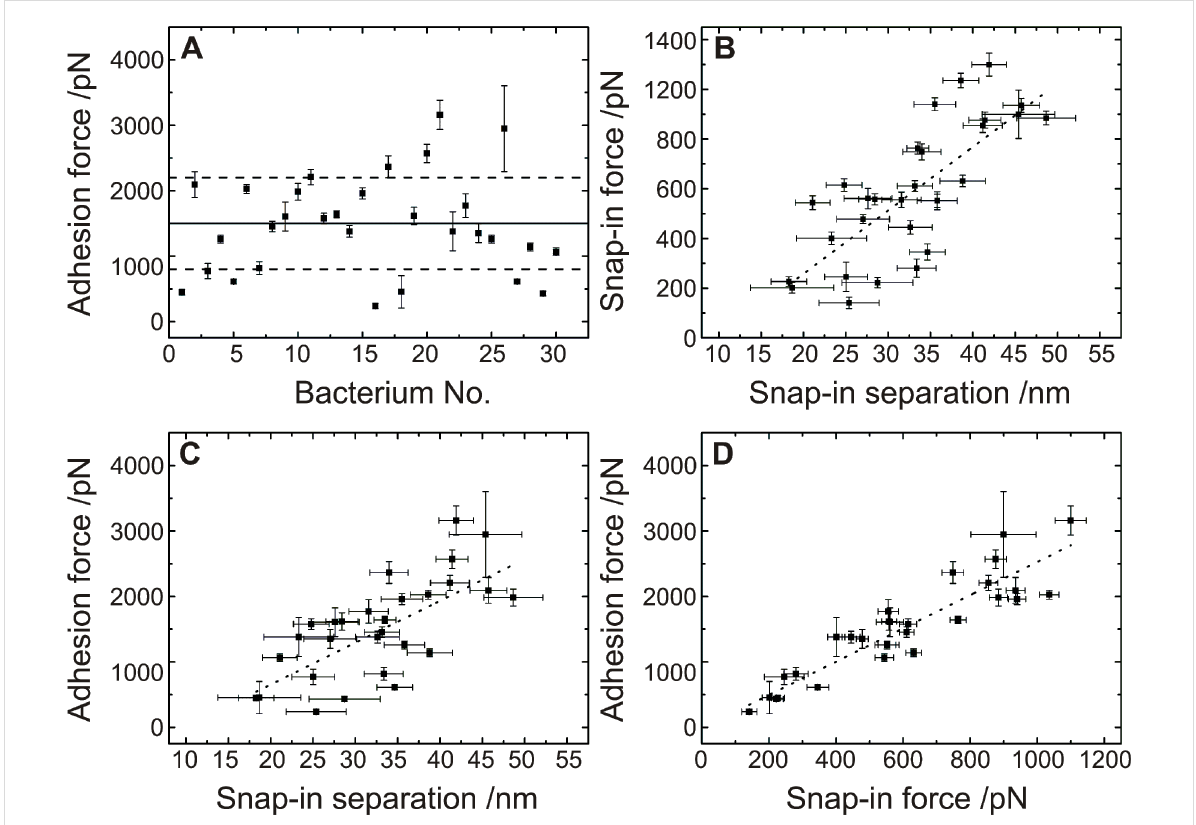
Figure 8: Results of 30 different single cell force spectroscopy experiments on OTS with S. carnosus bacterial probes, each data point consists of 30 force/distance curves with a force trigger of 150 pN and a tip velocity of 800 nm/s. A: Solid line: average adhesion force, dashed lines: range of the standard deviation. B–D: Dotted lines: linear fit to the